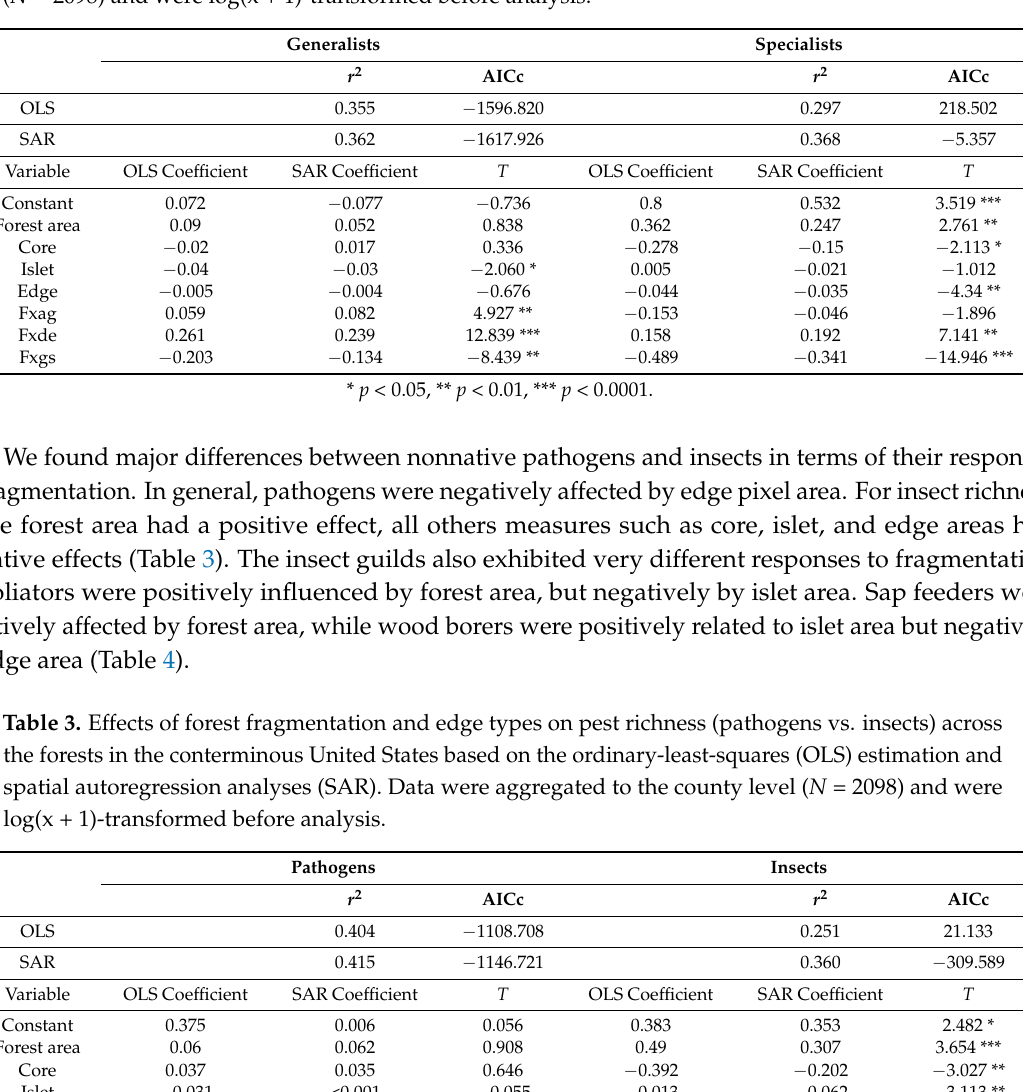
Table 2. Effects of forest fragmentation and edge types on pest richness (generalists vs. specialists) across the forests in the conterminous United States, based on the ordinary-least-squares (OLS) estimation and spatial autoregression analyses (SAR). Data were aggregated to the county level ( N = 2098) and were log(x + 1)-transformed before analysis.